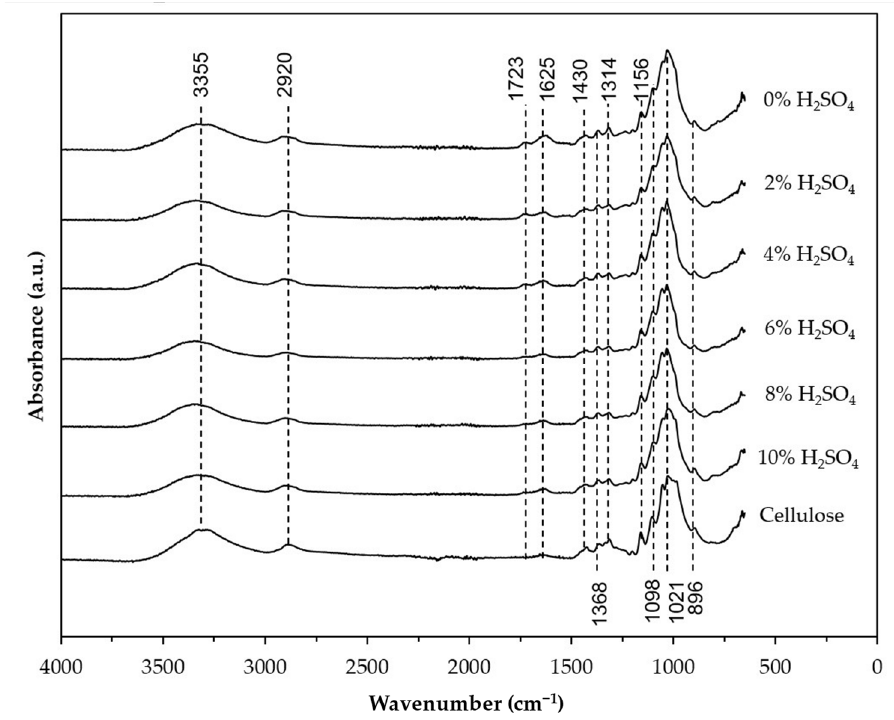
Figure 5. FTIR spectra of nanocellulose obtained after hydrolysis with of the H 2 O 2 pre ‐ treated banana peel using different H 2 SO 4 concentration (2%, 4%, 6%, 8%, and 10%). H 2 O 2 pre ‐ treated banana peel without the addition of H 2 SO 4 (0% H 2 SO 4 ) was used as a control The hydrolysis reaction was conducted at 80 °C for 1 h.